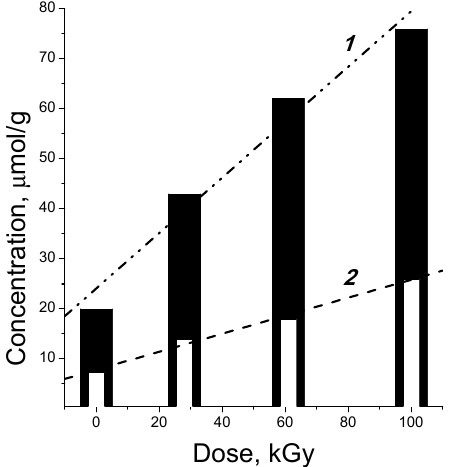
Figure 3. Accumulation of carbonyl (1) and carboxyl (2) groups during radiolysis of cotton cellulose [18].